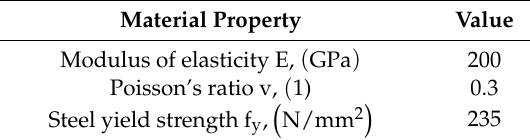
Table 9. Steel material data for FEM